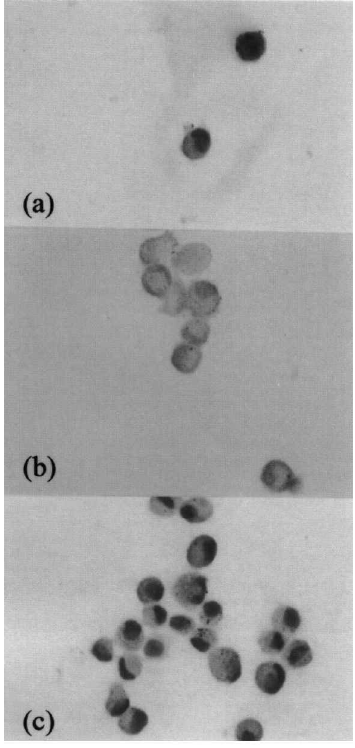
FIG. 2. Immunocytochemical staining of ICAM-1 on alveolar macrophages (AM) (A), and after treatment with TNF- a (B) from a patient with sarcoidosis. Staining for IgG 1 , as a negative control (C), on AM treated with TNF- a ( ´ 100). Using APAAP complex, ICAM-1 expression on AM from a patient with sarcoidosis was demonstrated. Staining of AM from a patient treated with TNF- a resulted in more intense coloring of the cell surface than staining of control AM.